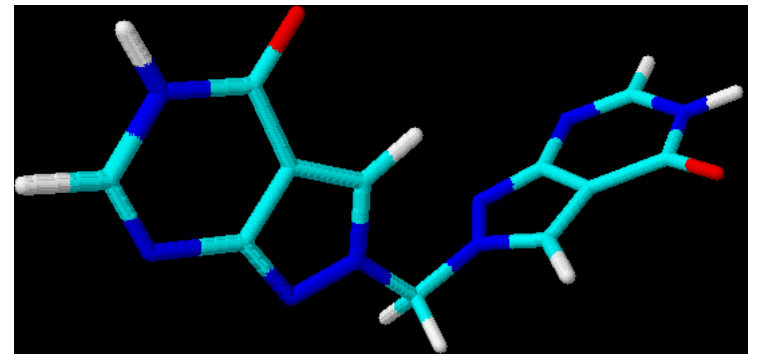
Figure 4 . 3D-Optimized structure of compound 5b [19].